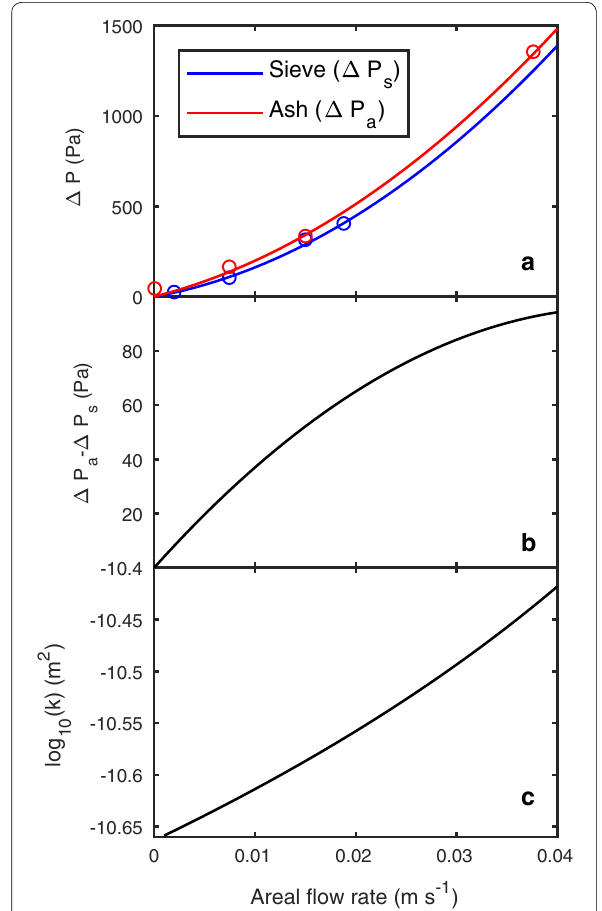
Fig. 12 Permeability measurement of powder-like ash. a Required pressure difference to cause a certain areal flow rate. The blue curve shows the measurement with the empty sieve, and the red curve shows that with the ash-filled sieve. b The difference between the measured pressures in ( a ). c Calculated permeability with a linear